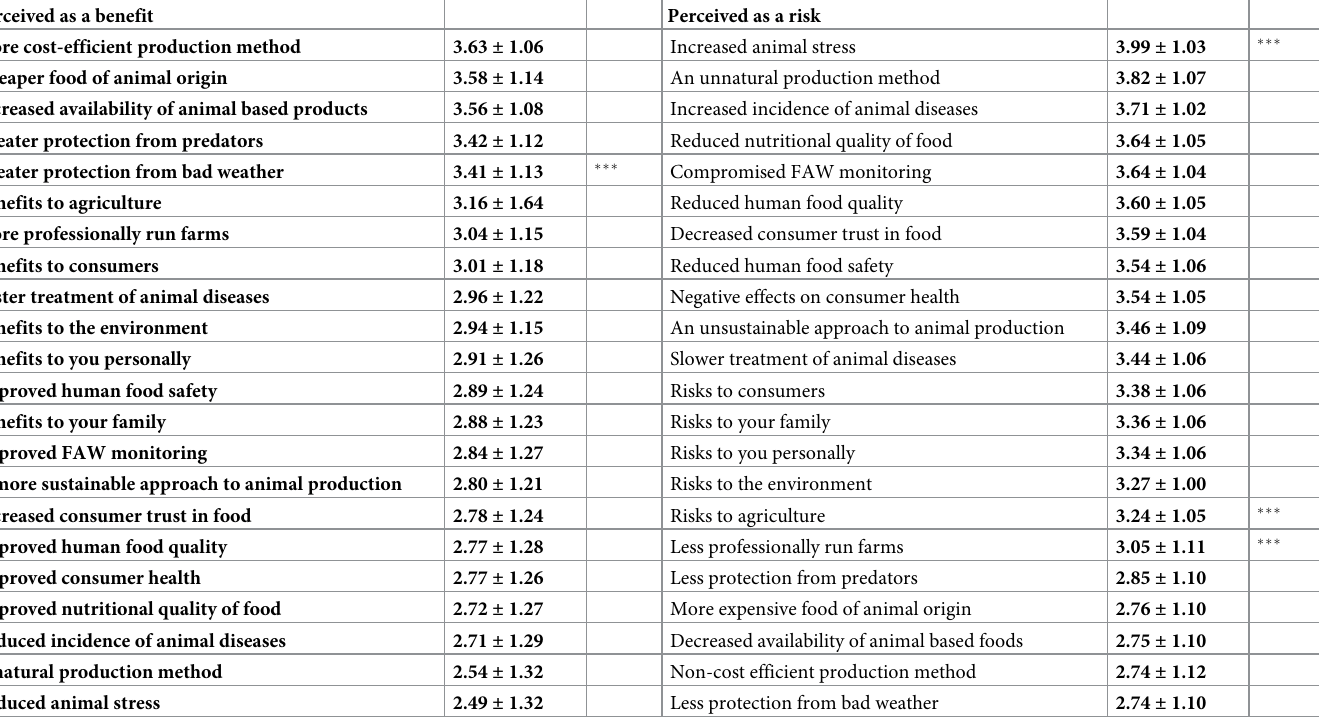
Table 2. Risk and benefit perceptions of respondents in the five study countries regarding intensive broiler chicken systems (mean response on a linear scale 1 (strongly disagree) to 5 (strongly agree) ± SD; n =